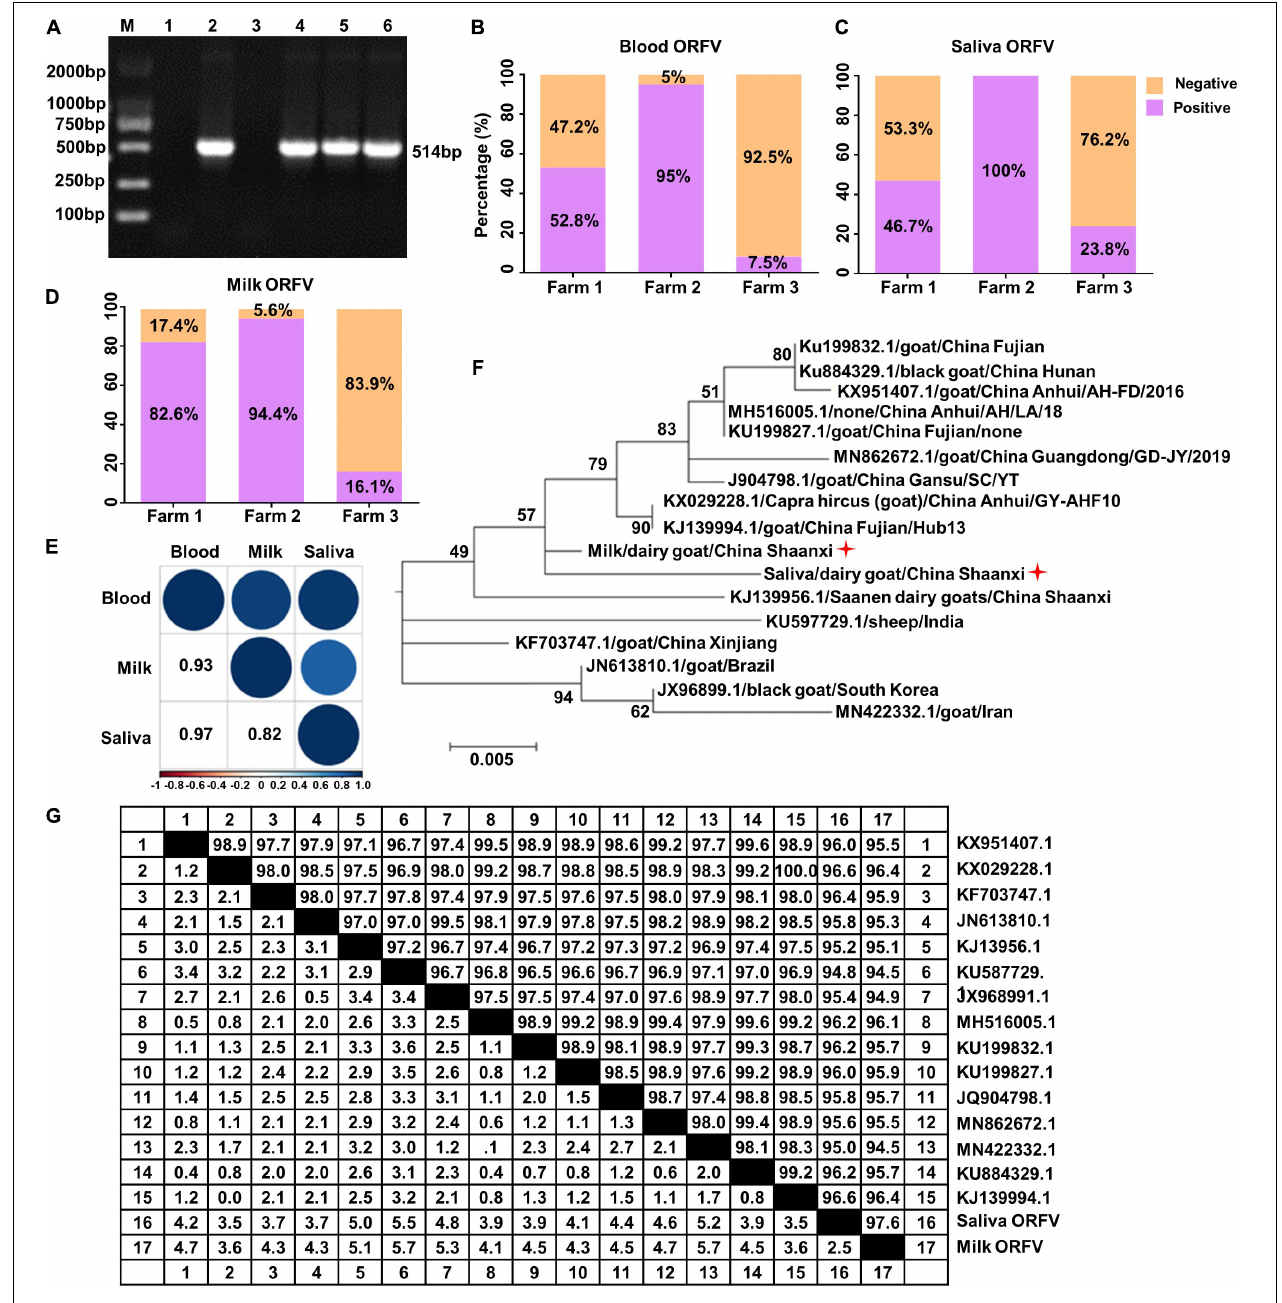
FIGURE 1 | Detection of ORFV in the saliva and milk of dairy goats. (A) Representative PCR results of ORFV B2L gene. M, DNA marker. Lane 1, negative control using double-distilled water instead of DNA template. Lane 2, positive control with DNA extracted from purified ORFV. Lane 3, DNA extracted from blood of ORFV negative dairy goat. Lane 4, ORFV from the peripheral blood of dairy goats. Lane 5, ORFV from the saliva of dairy goats. Land 6, ORFV from the milk of dairy goats. (B–D) Detection rates of ORFV from the peripheral blood, saliva and milk of dairy goats from three local farms. (E) Pearson’s correlation coefficient analysis based on ORFV detection rate of the peripheral blood, saliva and milk of dairy goats from the three farms. (F) Phylogenetic tree comparing B2L sequences of the saliva and milk ORFV isolated here (indicated by a red star) and other published B2L sequences. (G) Similarity comparison of the deduced B2L sequences of saliva and milk ORFV at the amino acid level with other published B2L